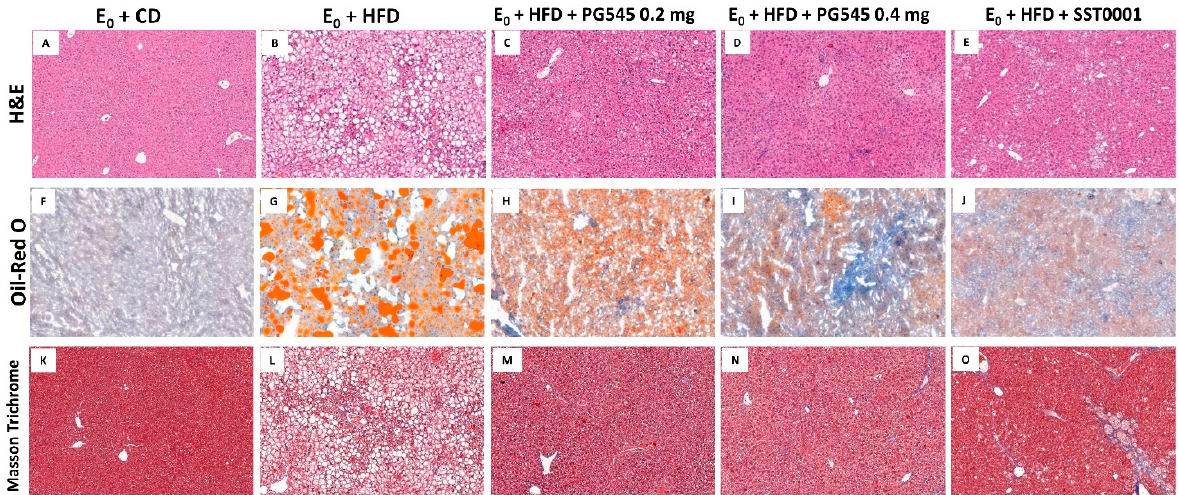
Figure 2. Effect of heparanase inhibition on liver steatosis. H&E, Oil-Red-O, and Masson’s Trichrome stainings of liver sections from E 0 mice on CD ( A – C ), E 0 mice on HFD ( D – F ), E 0 mice on HFD and PG545 low dose ( G – I ), E 0 mice on HFD and PG545 high dose ( J – L ), and E 0 mice on HFD and SST0001 ( M – O ).